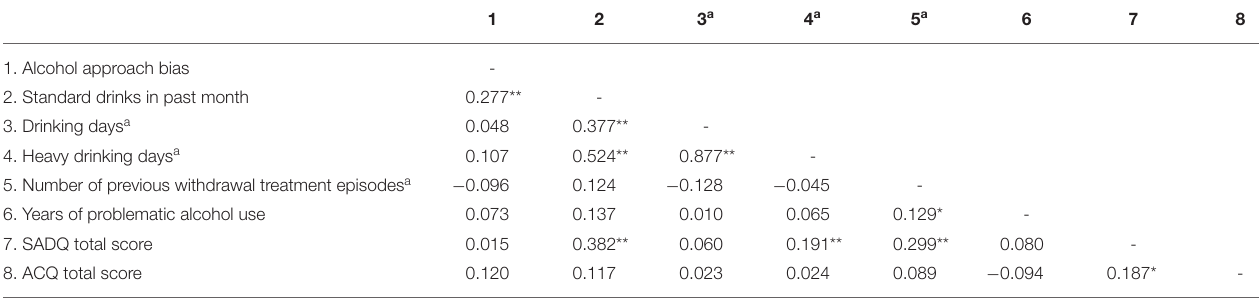
TABLE 2 | Pearson correlation matrix for indices of alcohol consumption and problem severity among those with an approach bias ( N =